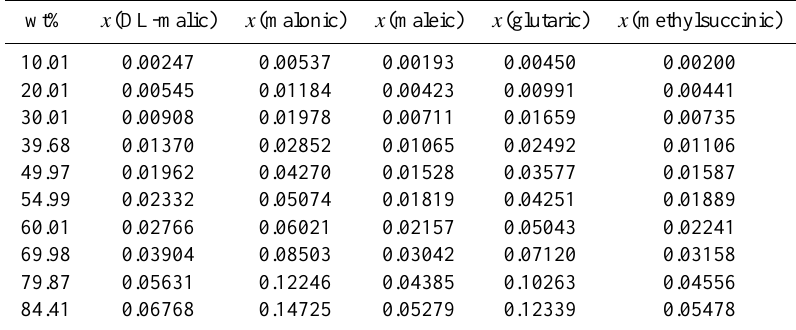
Table 9. EDB measurements: the total organic fraction of the solution is given in the first column in wt% and the composition in terms of individual components is given in mole fractions of the dicarboxylic acids constituting the M5 mixture.